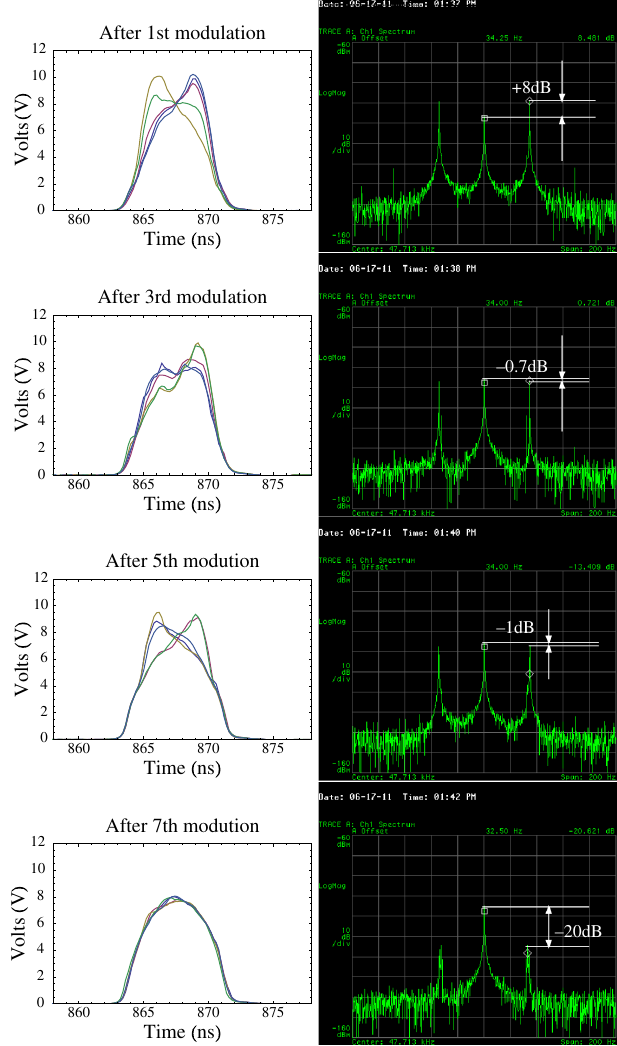
FIG. 10. These figures show the bunch dancing in both the time domain and the frequency domain before any modulating is done at 980 GeV. The synchrotron sidebands which are (cid:9) 34 : 75 Hz away from the first revolution harmonic are indi- cated in the lower picture.